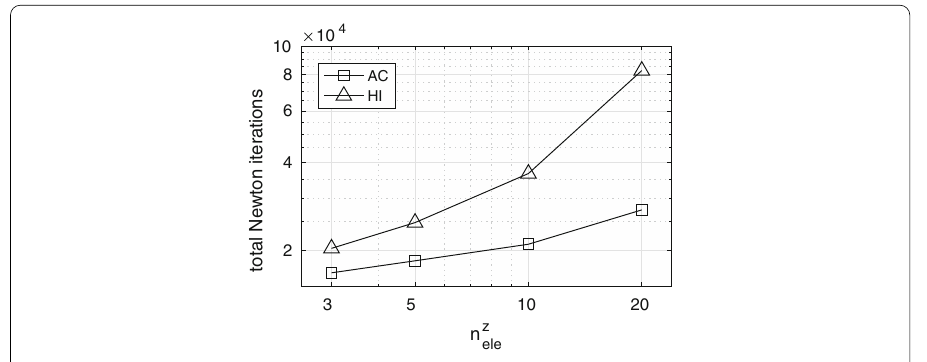
Fig. 21 Numerical efficiency of AC and HI in terms of total Newton iterations required